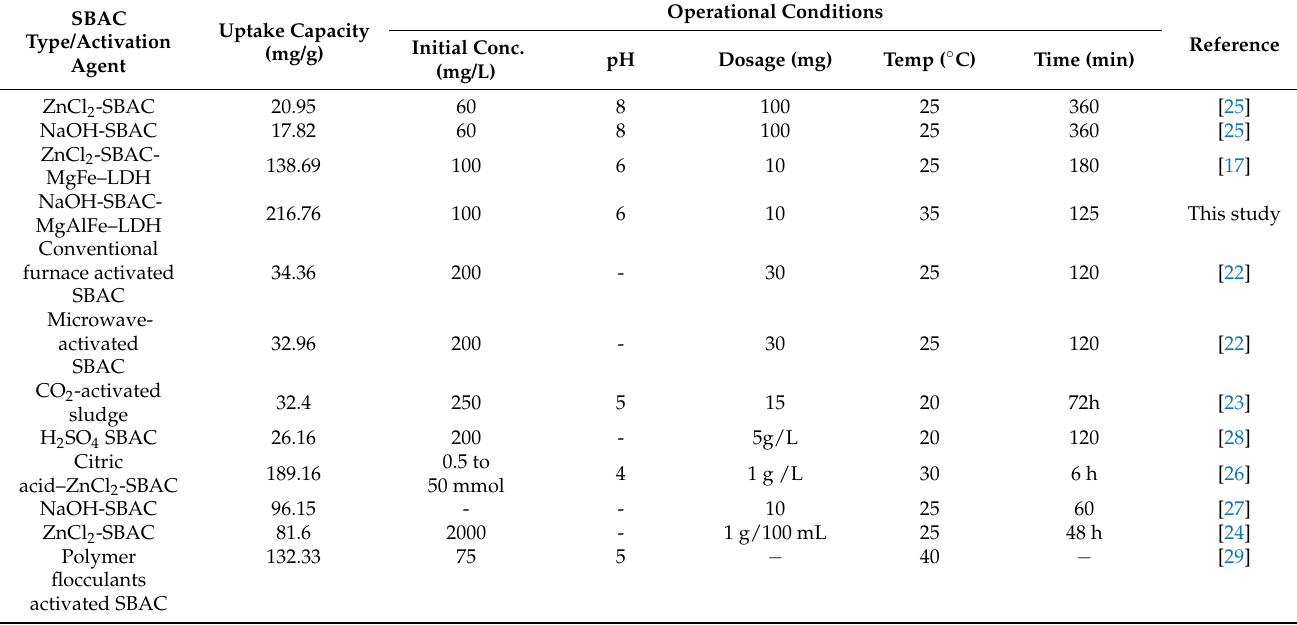
Table 6. Comparison of SBAC-MgAlFe-LDH phenol uptake capacity with other sewage sludge-based adsorbents produced using different activation